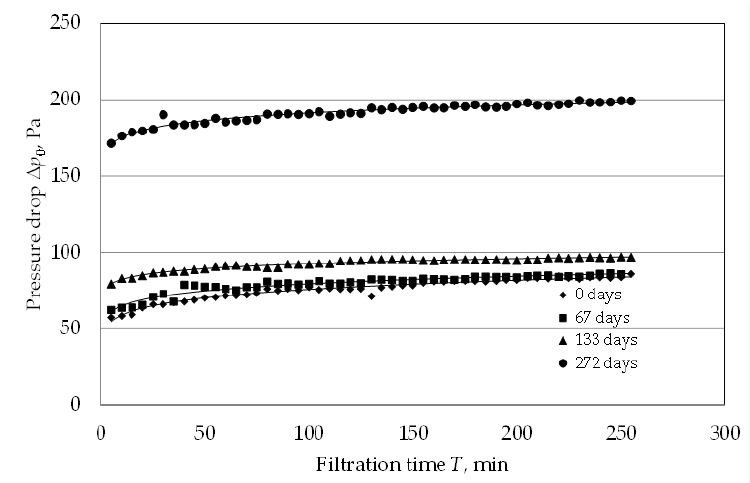
Figure 8. Flow resistance ∆ p c through the filter fabric from the line of drilling centers.